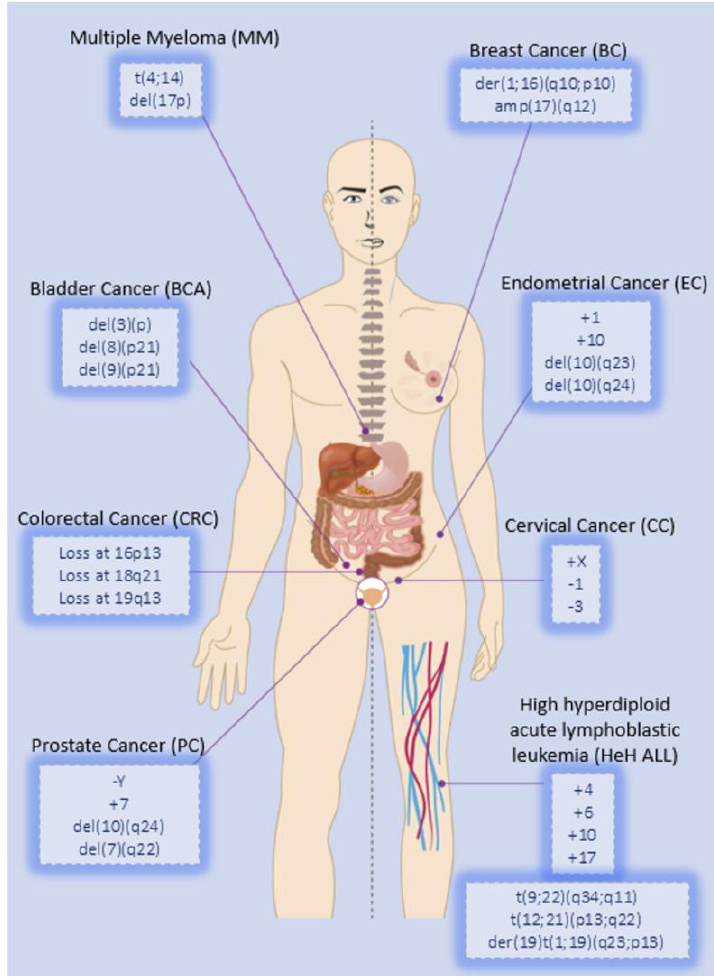
Figure 3. Chromosomal alterations most frequently observed in several types of cancer.